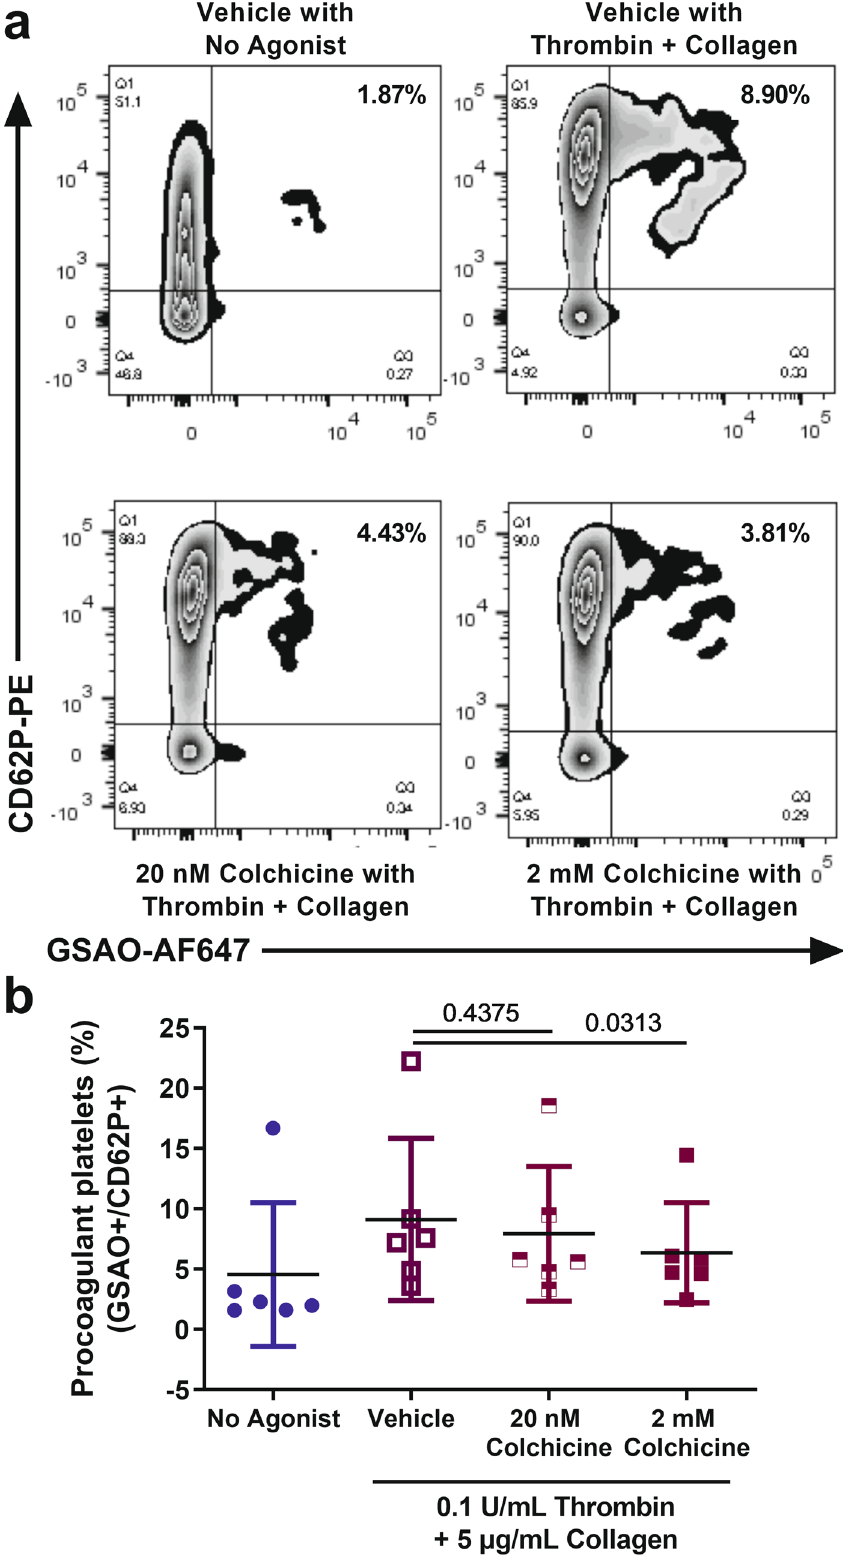
Figure 7. Colchicine inhibits the formation of procoagulant platelets. Washed platelets were subjected to dual stimulation with thrombin and collagen in the presence of vehicle, 20 nM or 2 mM colchicine, and the formation of procoagulant (GSAO + /CD62P + ) platelets determined with flow cytometry. ( a ) Representative zebra plots showing procoagulant platelets (GSAO + /CD62P + , top right quadrant) at rest or after dual stimulation with thrombin and collagen with vehicle, 20 nM or 2 mM colchicine pre-incubation. ( b ) Percentage procoagulant platelets at rest, and after stimulation in the vehicle control, 20 nM and 2 mM colchicine. Mean ± SD, n = 6, Wilcoxon test vs vehicle